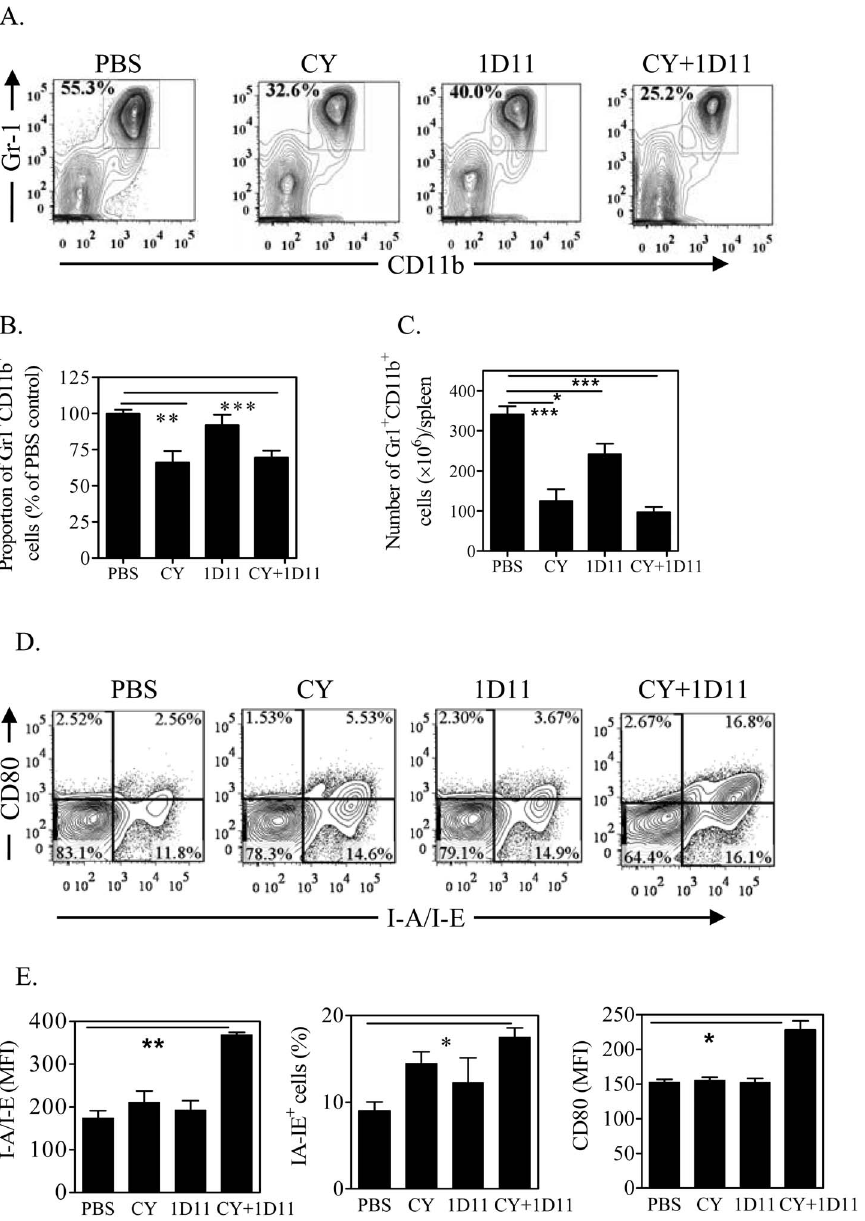
Figure 5. Combination treatment of 1D11 and CY reduces the number of splenic MDSCs and promotes their re-differentiation. Four weeks after 4T1 tumor inoculation, cell suspensions were prepared from spleen and MDSCs were analyzed by FACS, gating on live CD45 + cells. (A-B) Proportion and number of Gr1 + CD11b + cells in the spleens. Typical FACS plots are shown in (A, gating on total live splenic CD45 + cells) and summary of data pooled from three experiments are shown in (B, percent of PBS control group, Means 6 SEM, N=10 , 13). (C) Absolute number of Gr1 + CD11b + cells in the spleen (N=11, pooled from two separate experiments). (D-E) Expression of I-A/I-E and CD80 on Gr1 + CD11b + splenic cells. (D) Typical FACS plots (gating on Gr1 + CD11b + cells) and (D) summary of data pooled from three separate experiments (Means 6 SEM, N=9). Comparison of indicated groups, *p , 0.05, ** p , 0.01, ***p , 0.001.